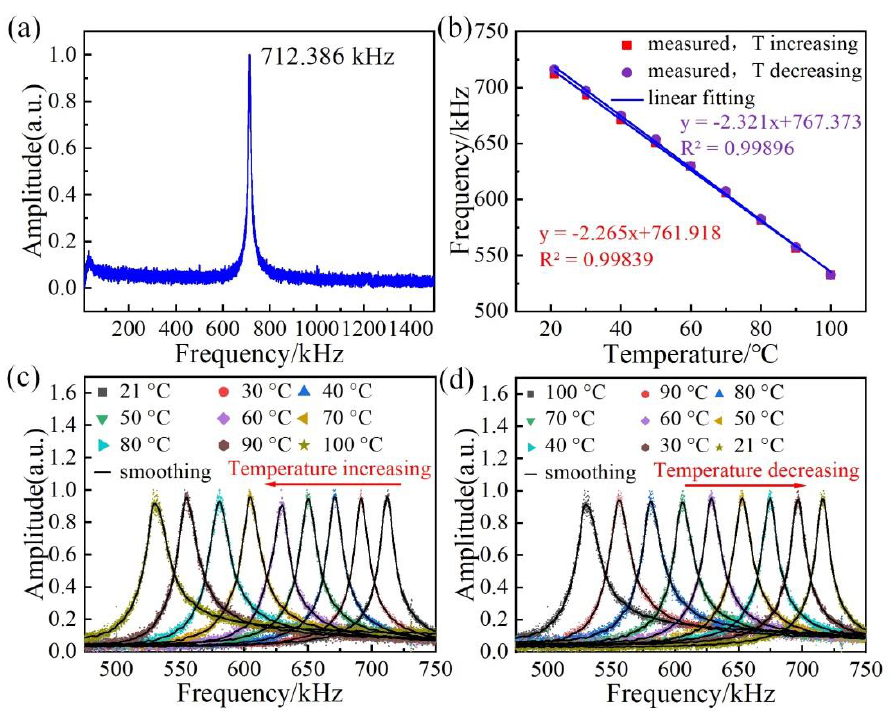
Figure 3. ( a ) Amplitude versus frequency for the fundamental mode of the resonator. ( b ) Resonance frequency ƒ as a function of the ambient temperature T during heating and cooling. ( c , d ) Frequency spectral evolution of the resonator, subject to different temperatures.